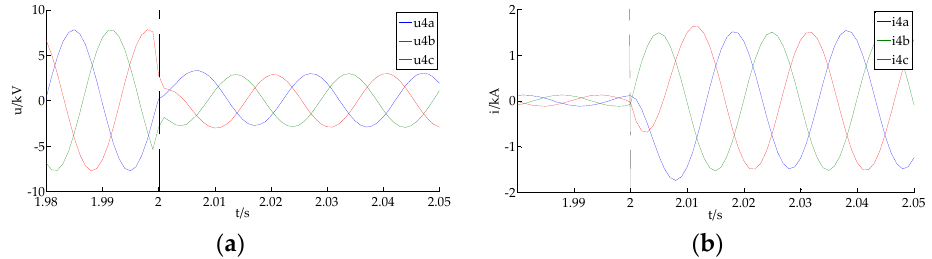
Figure 9. Voltage and current waveforms of Relay 3 during a three-phase fault at k2: ( a ) voltage; ( b ) current.